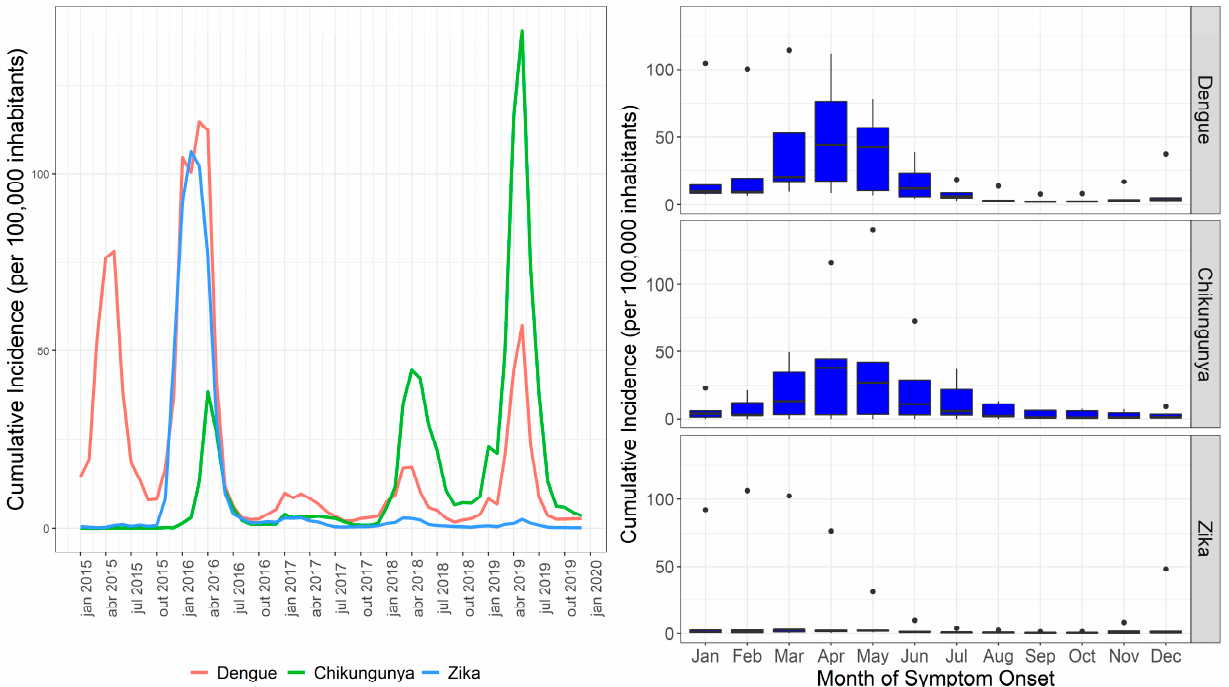
Figure 2. Dengue, chikungunya, and Zika, by month of symptom onset, Rio de Janeiro state, 2015–